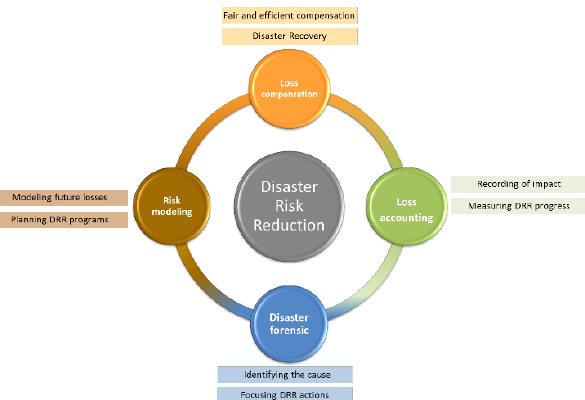
Figure 1. The four application areas of disaster loss data and their respective